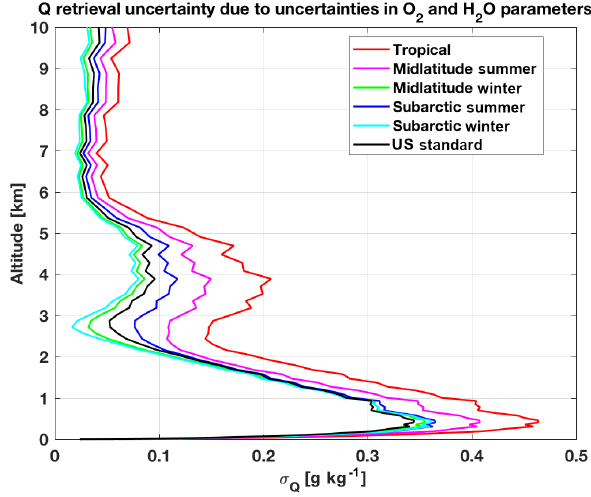
Figure 10. Uncertainty in temperature retrievals from ground-based MWR due to the uncertainty in O 2 and H 2 O absorption model pa- rameters. The observation vector considered here consists of T B at the 14 HATPRO channels. Six climatological atmospheric condi- tions (color coded) have been used to compute K b and K x . The square roots of the diagonal terms of Cov p are shown. 101 pressure levels from 0.005 to 1050hPa are used here. These levels have been selected specifically to be denser close to the surface (34 levels be- low 2km). The vertical spacing of levels is given in Fig. 1 of De Angelis et al. (2016).